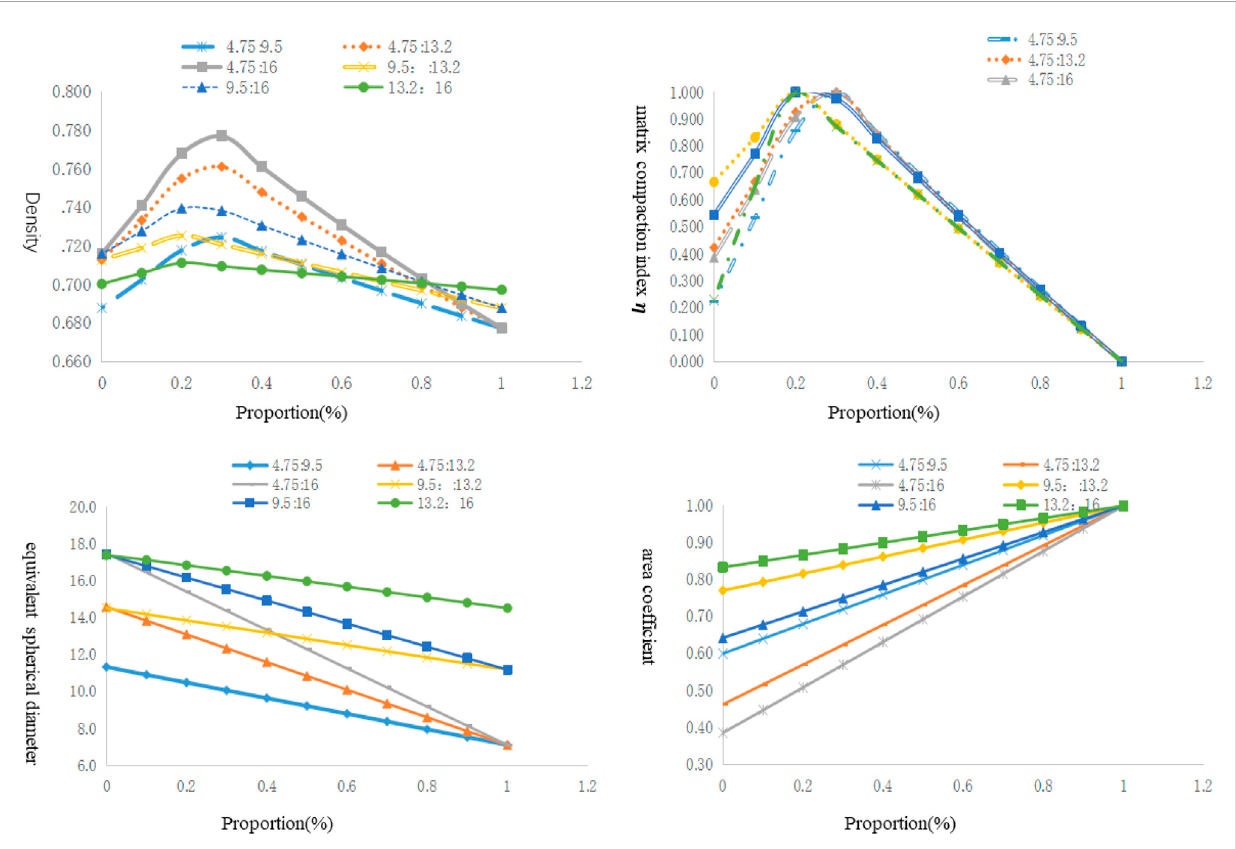
FIGURE 2 Variation diagrams in binary